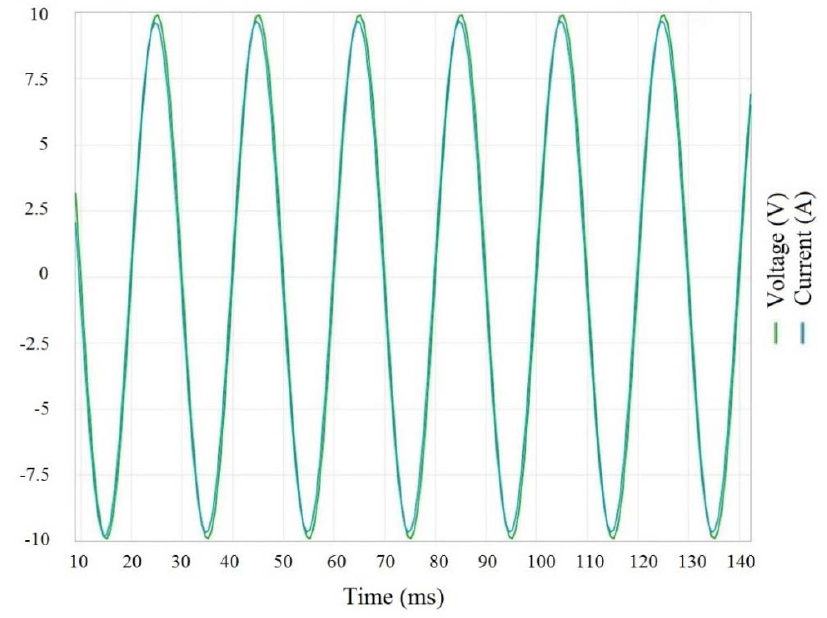
Figure 13. The PMSM stator voltage and current signals achieved in simulation model (where the voltage and the current signals coincidence).